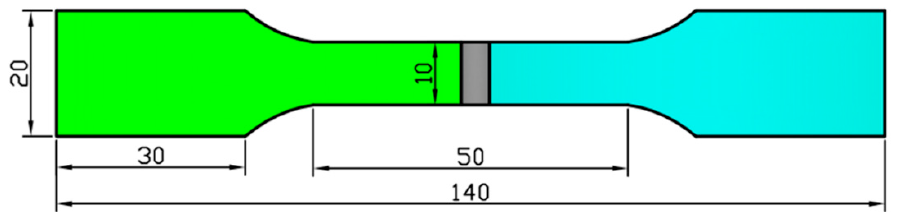
Figure 1. The schematic drawing for tensile testing (mm).